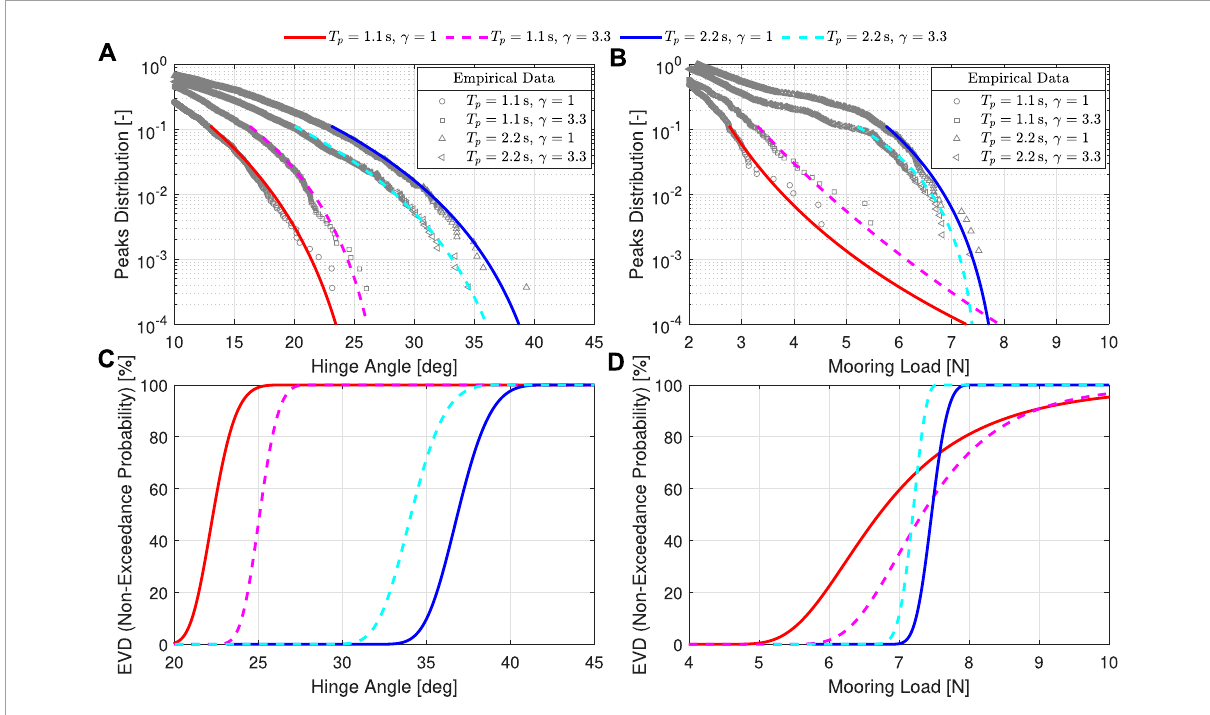
FIGURE 5 Empirical distributions (grey markers) and Generalised Pareto Distribution fit (solid lines, γ = 1; dashed lines γ = 3 . 3) of the observed peaks for the hinge-angle (A) and mooring load (B) for the 1-h irregular sea states. The corresponding non-exceedance EVDs is also presented for the hinge-angle (C) and mooring load (D)